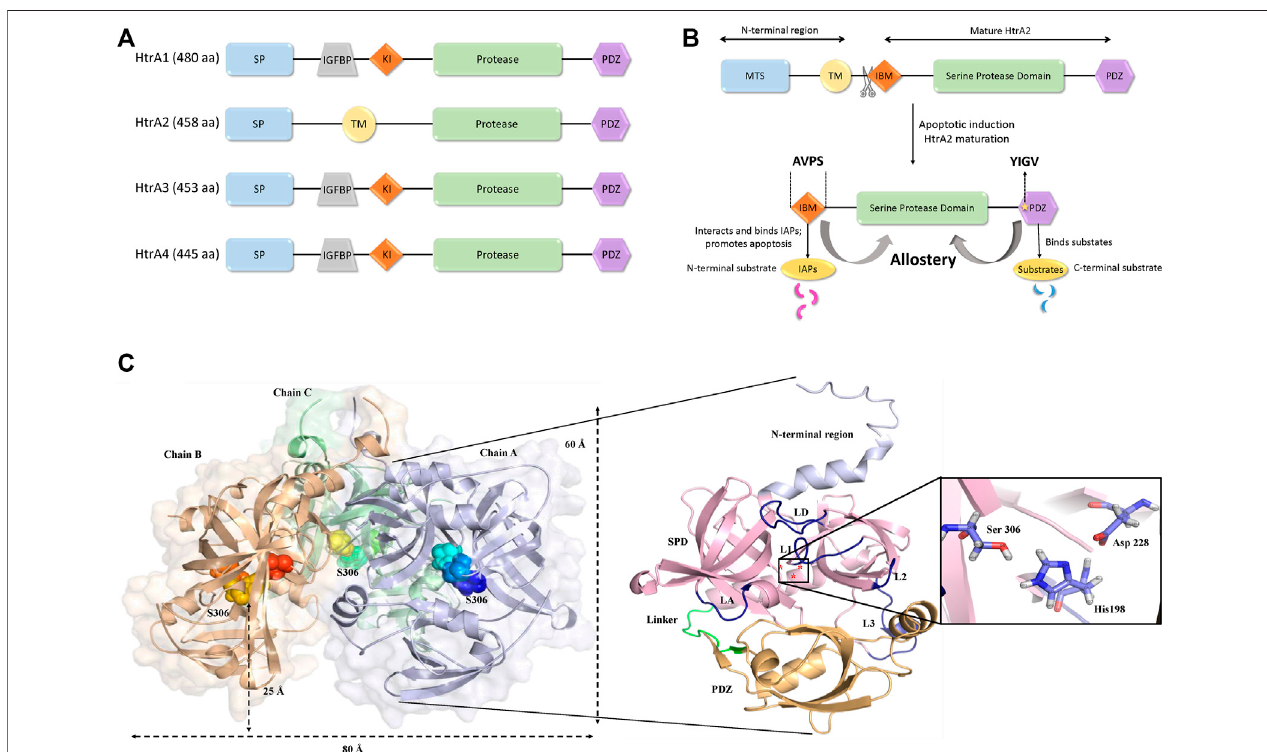
FIGURE1| StructuralorganizationofHtrA2. (A) ComparisonofdomainorganizationsofthehumanHtrAfamilyincludingHtrA1,HtrA2,HtrA3andHtrA4.aa,amino acid; SP, signal peptide; IGFBP, insulin growth factor binding domain; KI, Kazal-type S protease inhibitor domain; protease, protease domain; PDZ, PDZ domain; TM, transmembrane regulatory domain. (B) Schematic representation of the full-length HtrA2 protein (1 – 458 aa) and its different components as shown in the fi gure. Upon apoptotic trigger, the mitochondrial localization signal (133 residues) from theN-terminus gets cleaved exposing a tetrapeptideIAP-binding motif (IBM/AVPS), and concomitantlyreleasingtheproteaseintothecytosol.SubsequentsubstratebindingatN-and/orC-terminileadstoallostericproteaseactivationandsubstratecleavage as described in the text. (C) The three-dimensional trimeric model adopted from the crystal structure (PDB ID: 1LCY) of HtrA2 highlighting the hidden catalytic triad (rainbow spheres) 25 Å above base of the pyramid (left side) while a single monomer has been zoomed into for describing the loops (yellow) and domains (N-terminal region: light purple, SPD: pink, PDZ: orange); the catalytic site has been shown in the inset (right side). L1, L2, L3 and LD are loops; SPD is serine protease domain and Linker represents the fl exible region between the SPD and PDZ domain.